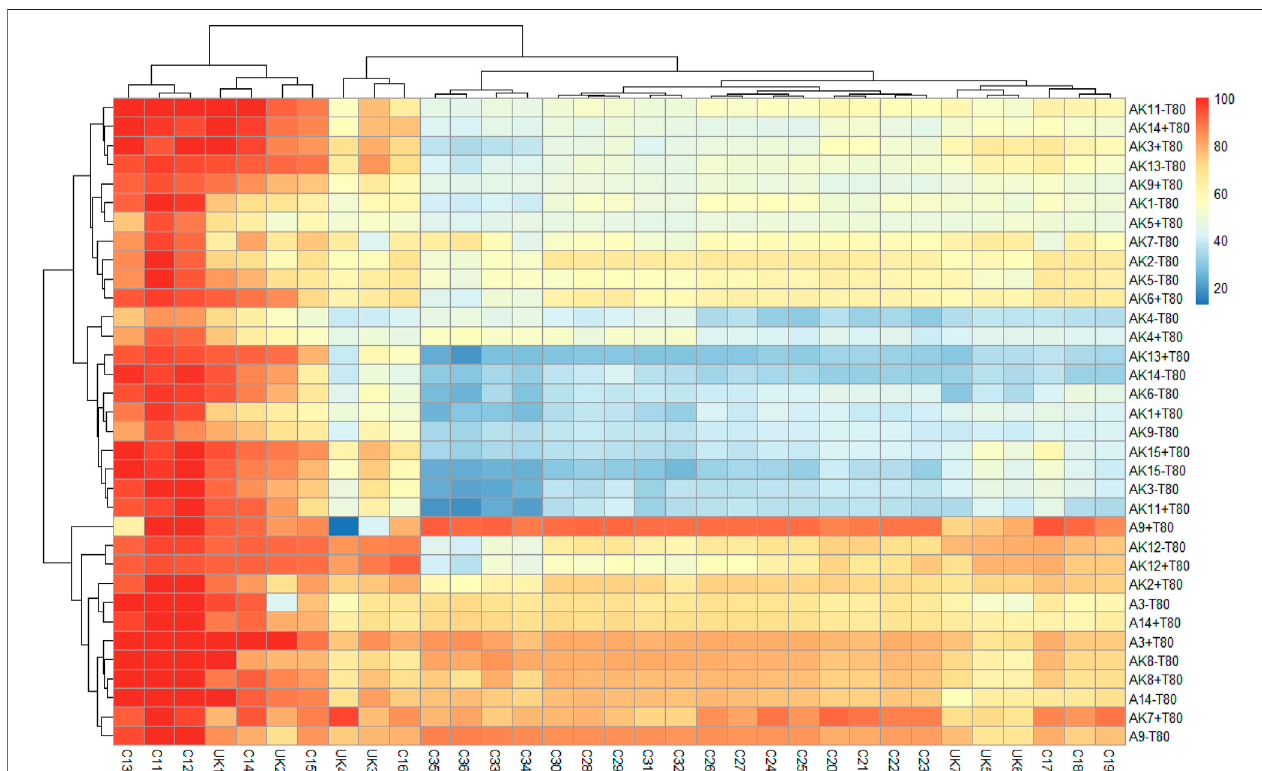
FIGURE1| Heatmapshowingpercentdegradationofaliphatichydrocarbonsinthecrudeoilbydifferentbacteriainmineralsaltsmedium,without( − T80)andwith Tween-80 (+T80). [AK1- Lysinibacillus sp.; AK2- Arthrobacter pascens ; AK3- Bacillus aryabhattai ; AK4- Kocuria rosea ; AK5- Arthrobacter sp.; AK6- Kocuria fl ava ; AK7- Pseudomonas aeruginosa ; AK8- Bacillus megaterium ; AK9- Nocardioides sp.; AK11- Bacillus sp.; AK12- Pseudomonas sp.; AK13- Sporosarcina luteola ; AK14- Bacillus niacin ; AK15- Bacillus siamensis ; A3- Pseudomonas sp.; A9- Bacillus amyloliquefaciens ; A14- Staphylococcus sp.; alkanes C11 – C36 represents as undecane (C 11 H 24 ), dodecane (C 12 H 26 ), tridecane (C 13 H 28 ), tetradecane (C 14 H 30 ), pentadecane (C 15 H 32 ), hexadecane (C 16 H 34 ), heptadecane (C 17 H 36 ), octadecane (C 18 H 38 ), nonadecane